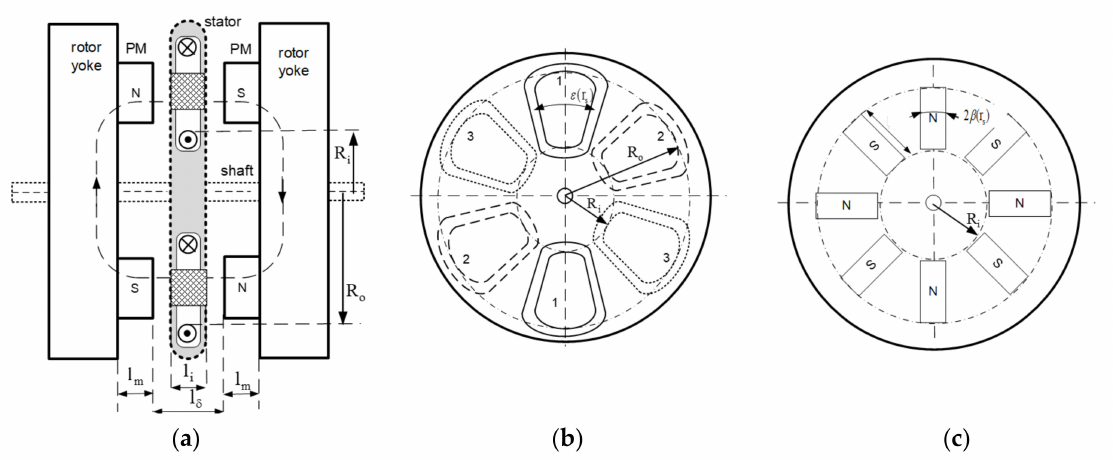
Figure 2. Construction of an AFPMG: ( a ) cross section, ( b ) stator, ( c )